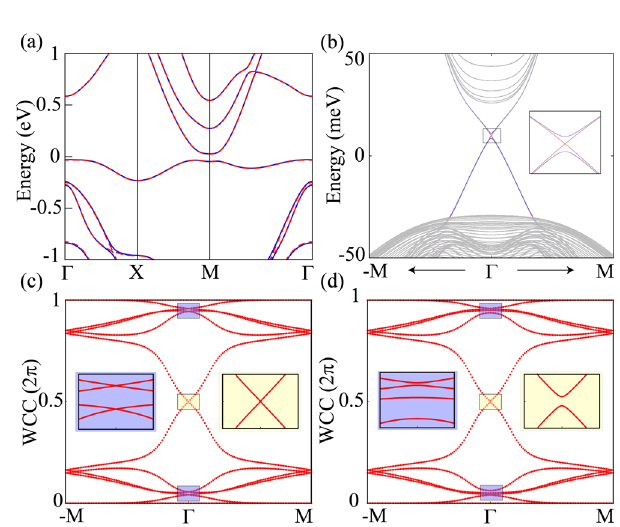
Fig. 3 The electronic structures of Wannier Hamiltonian ̂ H 0 and those with additional S z symmetry ̂ H S . a Band structures of ^ H S (red dash line) and ^ H 0 (blue solid line). b Edge states of the ^ H S (red) and ^ H − 0.1 eV. c , d The Wilson loop 0 (blue), with a surface onsite energy spectra of all occupied bands in ^ H S and ^ H 0 ,